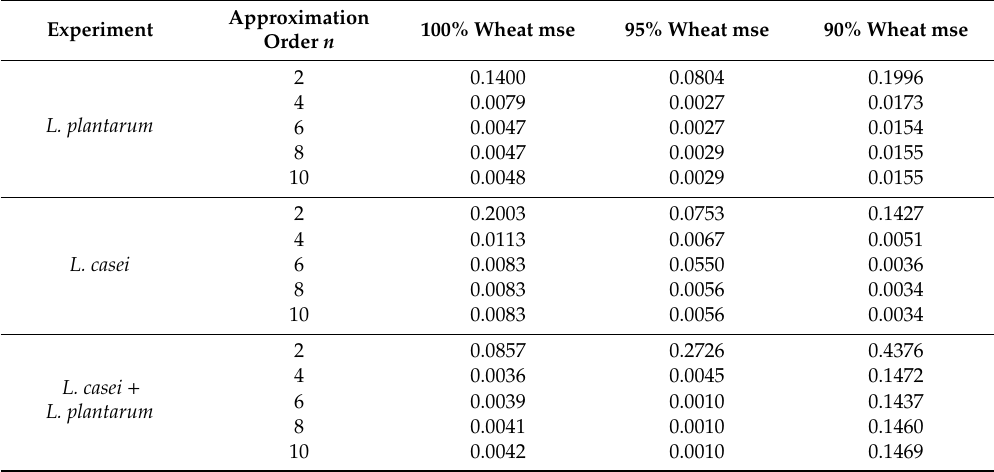
Table 3. Algorithm mean squared error (mse) for di ff erent fractional-order approximations n